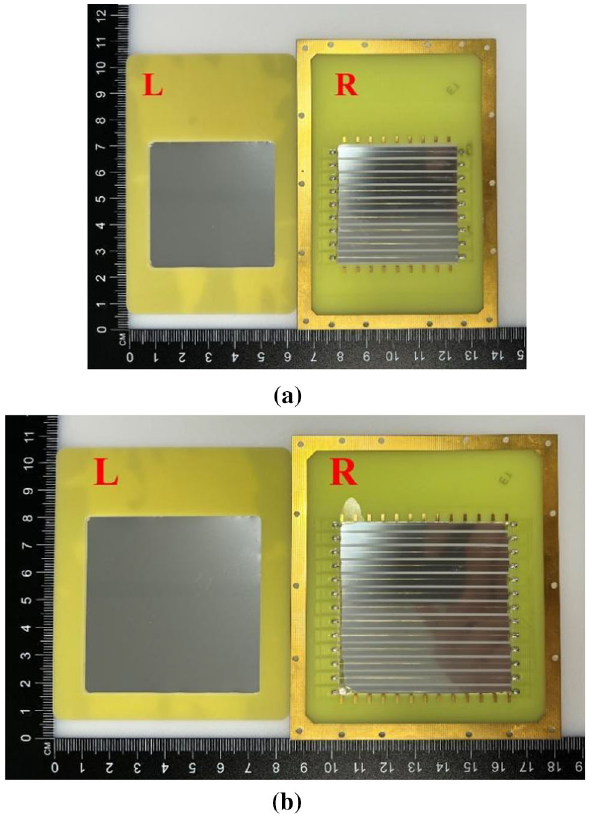
Fig. 3 Comparison of incoming sealed window ( a ) and outgoing sealed window ( b ). L: a double-sided aluminized mylar film structure window, R: a Split-strip Aluminized mylar film structure